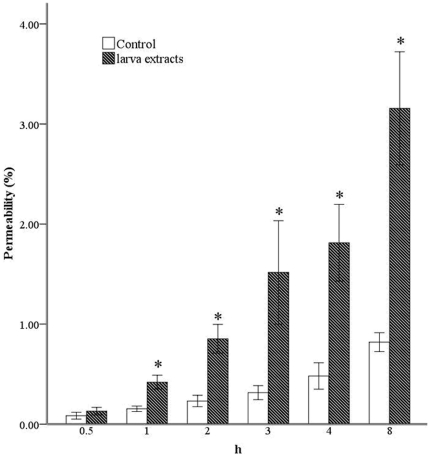
Analysis on HRP Permeability of BBB model with or with A. cantonesis larvae extracts.Samples were collected from the donor and receiver tanks to calculate HRP permeability at 0.5, 1, 2, 3, 4, 8 h after larvae extracts were added to the BBB cell model, showing that the HRP permeability started to increase significantly in larvae extract group after 1 hour. Data are presented as the mean ± SD of three experiments. * P<0.01, larvae extract group vs. control group at each point in time.